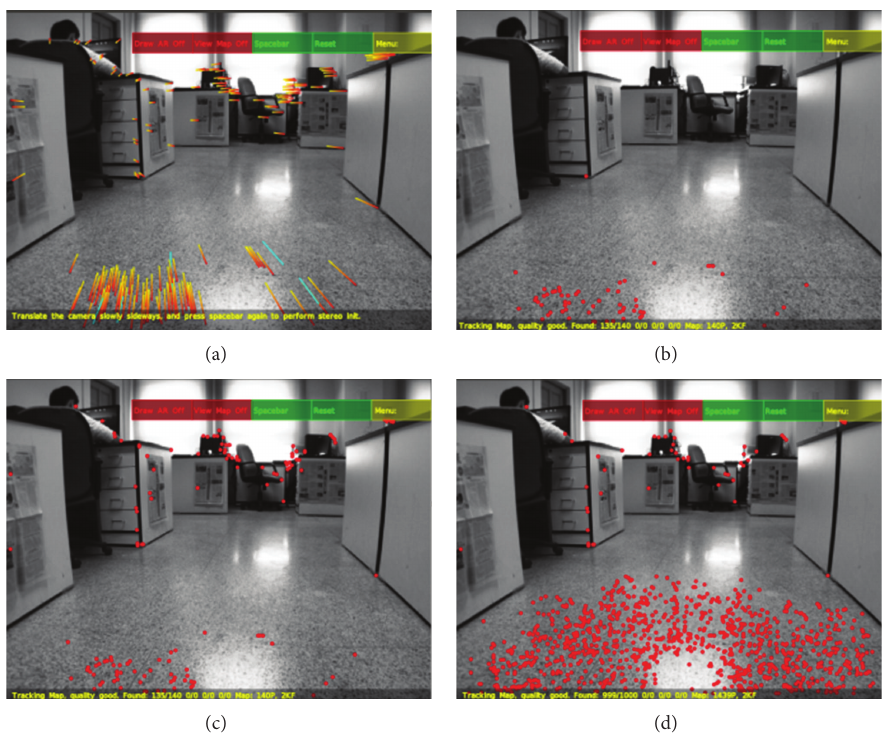
Figure 3: The procedure of initialization: (a) illustrates the tracking of features, the detected ground features are shown in (b), (c) shows all the matched features, and (d) demonstrates the initial map after epipolar